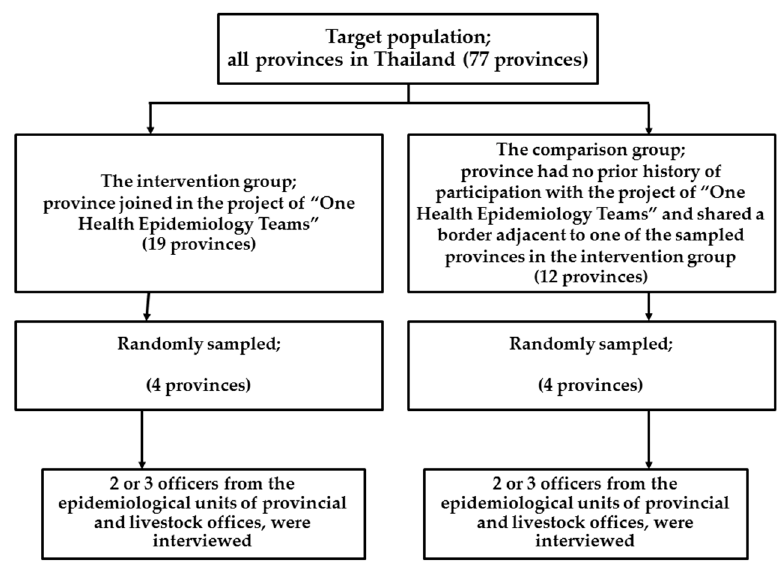
Figure 1. Flow chart of study population: assessment of epidemiology capacity in One Health teams at the provincial level in Thailand.